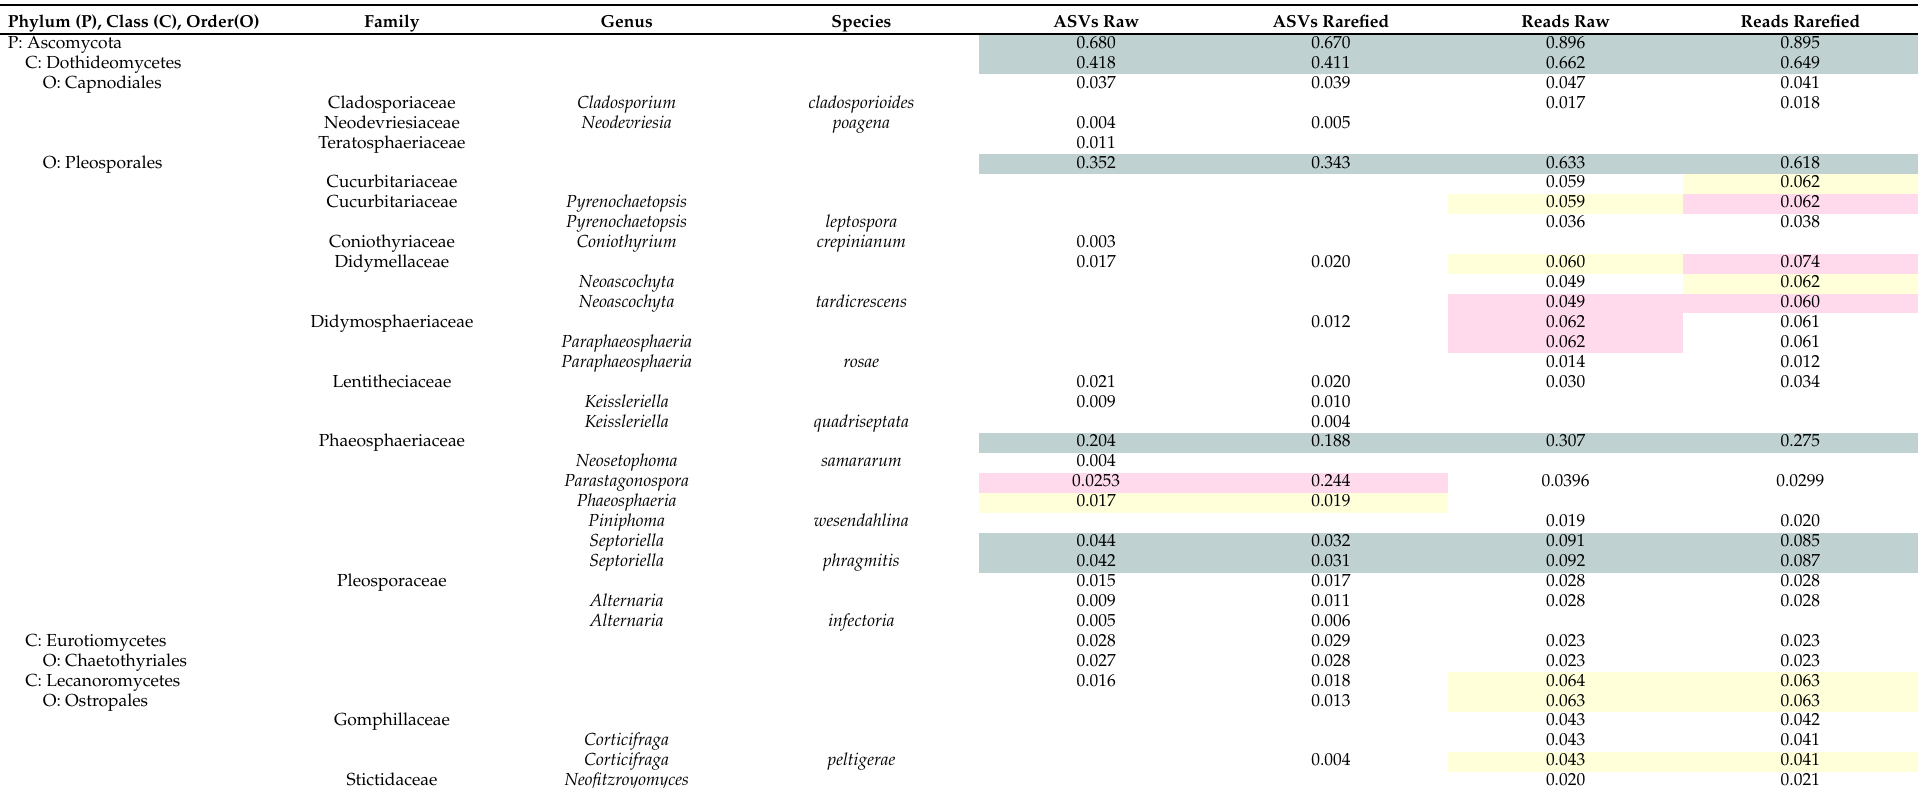
Table 1. Most common taxonomic groups by amplicon sequence variants (ASVs) occurences or the number of reads, using either the raw data or the rarefied data. In each case the proportions of the totals are shown. For each taxonomic category and measure of abundance (columns), the most abundant taxon is highlighted in blue-green , the second most abundant is highlighted in rose and the third most abundant is highlighted in yellow . Note that species identities listed here are only tentative; see Section